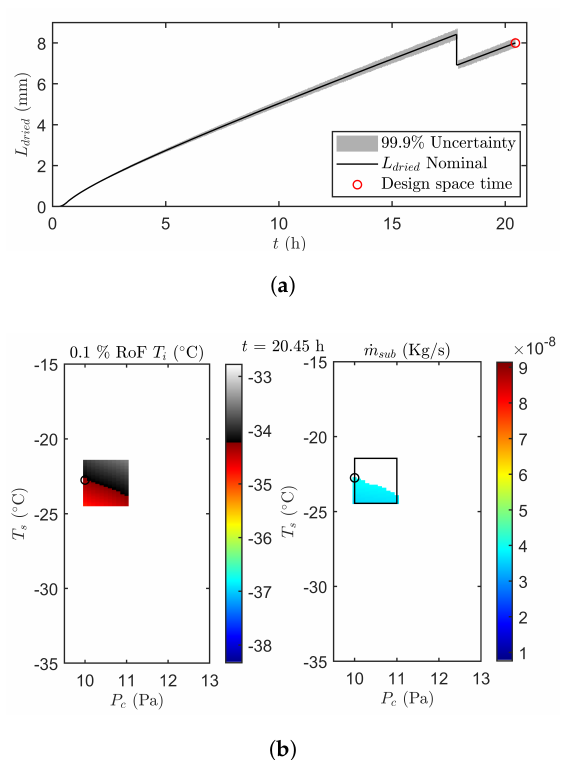
Figure 7. ( a ) The error propagation of L dried until time point 20.45 h (red circle). ( b ) Design space for a risk of failure of 0.1 % for T i (left) and ˙ m sub (right) after 20.45 h of the second undisturbed verification run. Please note that the black box represents the machine capability space centered around the previous combination of manipulated variables. White and gray-scale points in the box are invalidated due to their high RoF. The black circle depicts the most optimal next operating point within the design